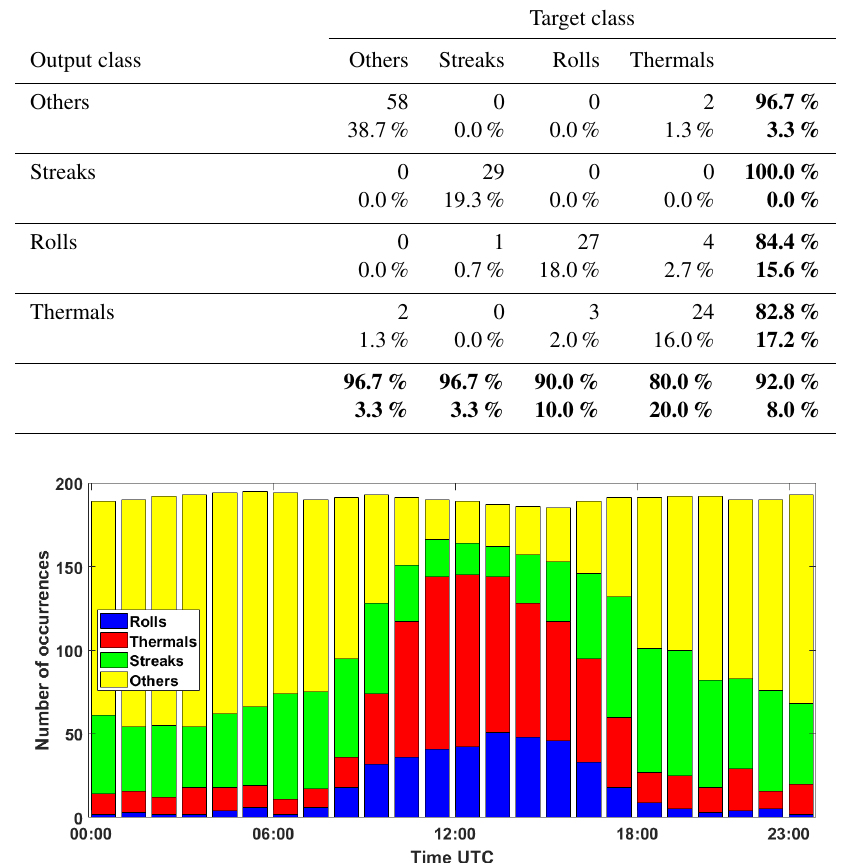
Figure 10. Histogram of the number of occurrences of the different types of structures with respect to time in